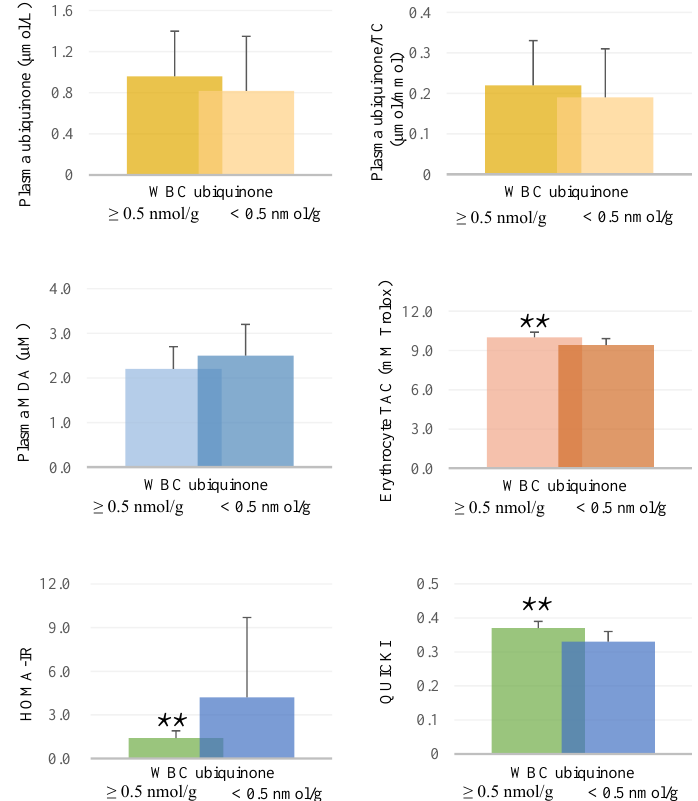
Figure 2. Plasma ubiquinone, oxidative stress, total antioxidant capacity, and glycemic parameters stratified by WBC ubiquinone after supplementation ** p < 0.01. HOMA-IR, homeostatic model assessment-insulin resistance; MDA, malondialdehyde; QUICKI, quantitative insulin sensitivity check index; TAC, total antioxidant capacity; TC, total cholesterol; WBC, white blood cell. 3.3. Correlations between Ubiquinone Status and Oxidative Stress, Total Antioxidant Capacity, and Glycemic